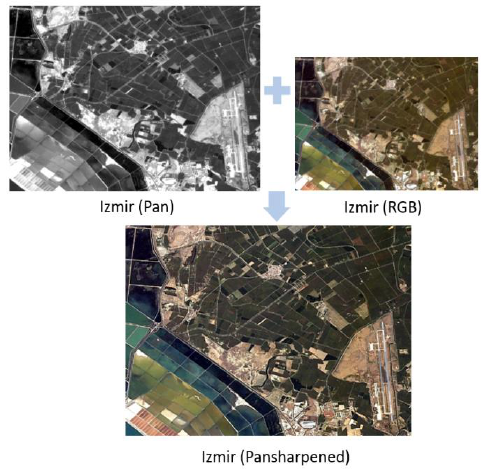
Figure 5. RASAT Imagery Panharpening Process